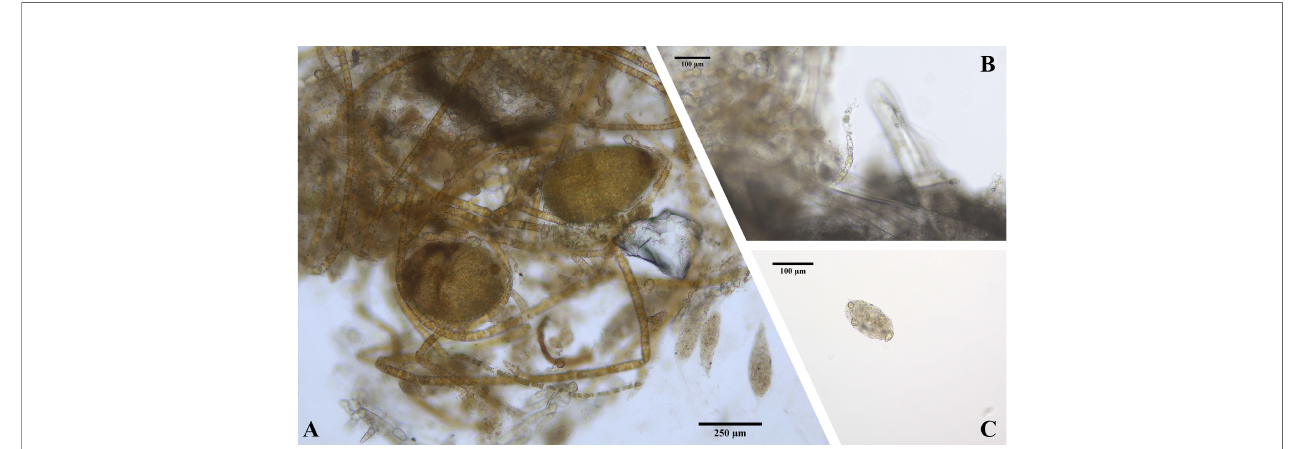
FIGURE 6 | Different stages of E. radiata microscopic stages in faecal matter of the herbivore A. atkinsoni . (A) Juvenile sporophytes growing in aggregated clumps of gametophytes and faecal matter. (B) Filament of gametophyte growing out of faecal matter. (C) E. radiata spores in